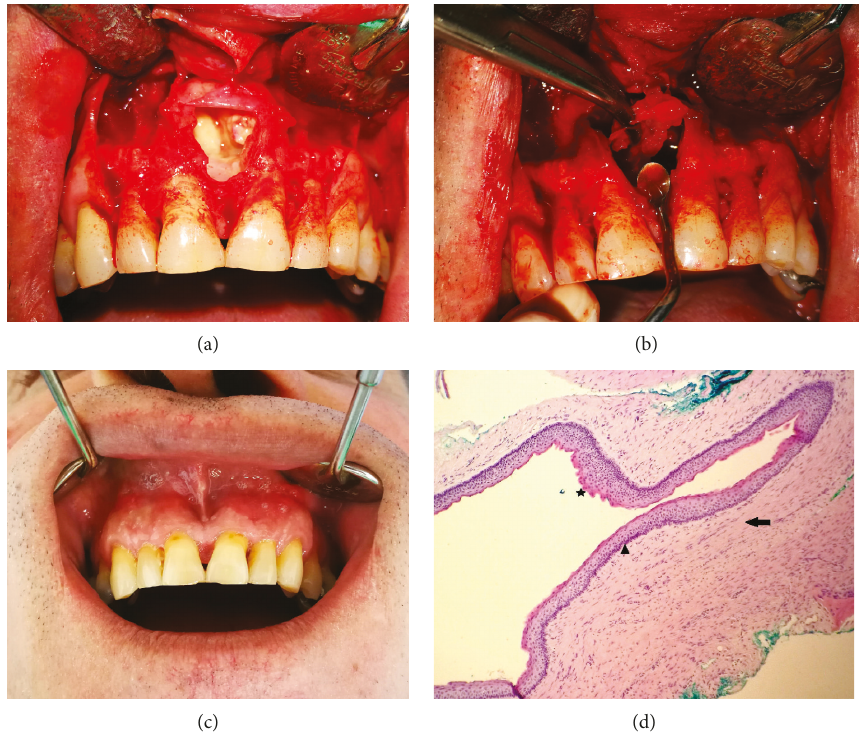
Figure 11: (a) Destruction of the vestibular lining of the maxillary bone through which the thick cystic content can be seen. (b) Enucleation of a cystic capsule. (c) Clinical appearance of the upper vestibule a month after surgery. (d) Typical histology of an odontogenic keratocyst (OKC). Unin fl amed fi brous wall lined by a thin regular parakeratinized epithelium, 5-8 cell layers thick (arrow). The parakeratinized surface is corrugated (star) and the basal layer is palisaded with hyperchromatic nuclei